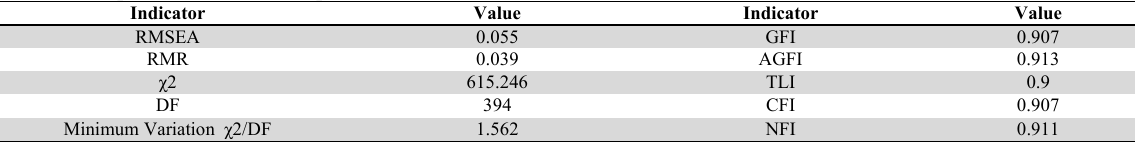
Indicators of perfect fit of the independent variables dimensions